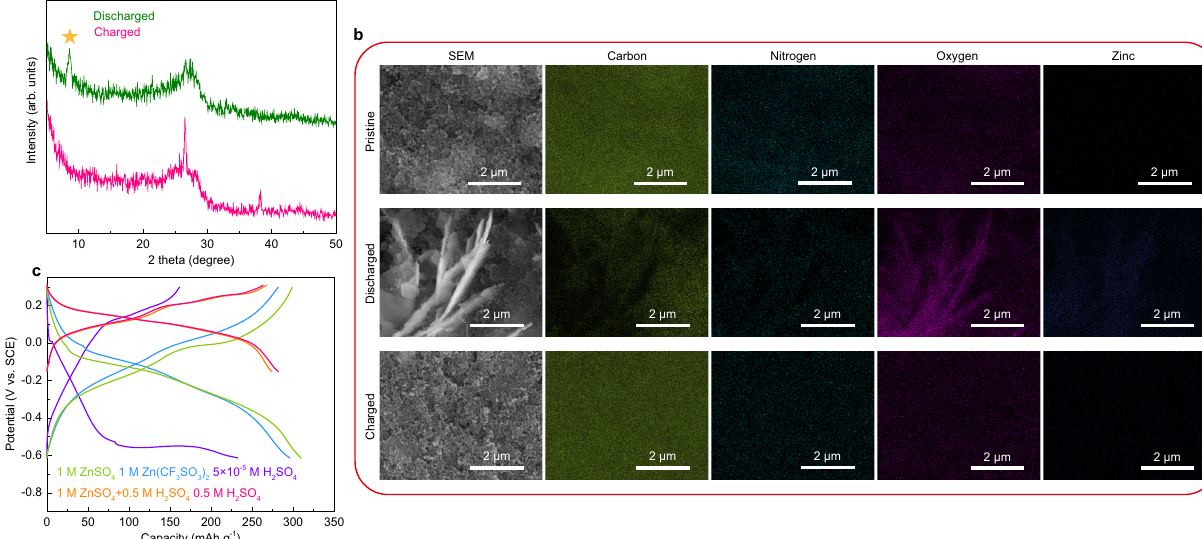
Fig. 4 Proof of proton insertion in TABQ. a XRD of TABQ at the end of discharge and charge (the asterisk shows the characteristic diffraction peak of Zn 4 SO 4 (OH) 6 ·4H 2 O). b SEM images and EDS mappings of TABQ at different states. c Charge/discharge curves of TABQ in three electrode cells with SCE reference electrode and different